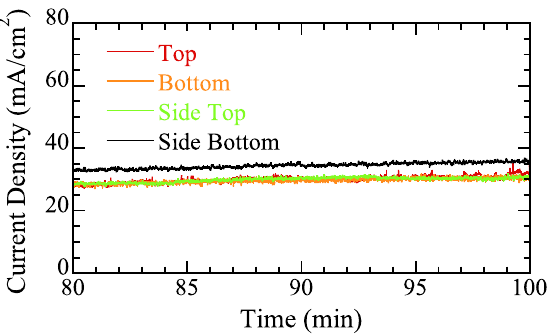
FIG. 14. Optical microscope images of the Nb samples EPed at a stirring speed of 210 rpm. Insets show zoomed-out views of the surfaces.